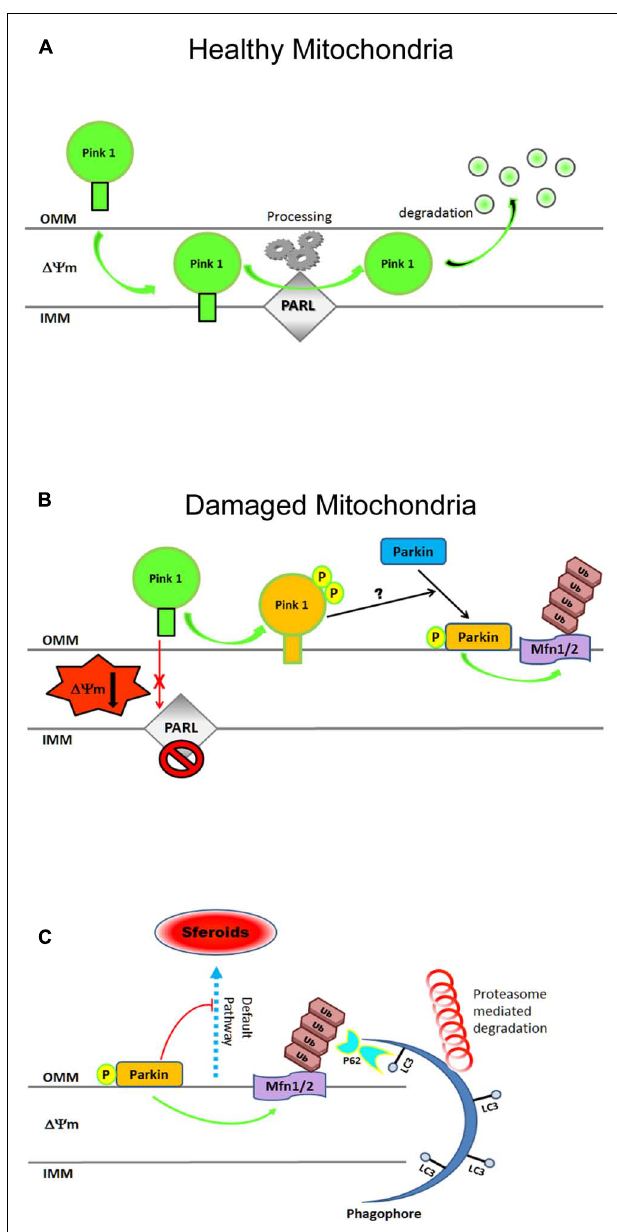
FIGURE 3 | Cartoon illustrating steps in the mitochondrial clearance mediated by the Pink1–Parkin pathway. (A) In physiological conditions, Pink-1 is constitutively imported into healthy mitochondria viaTIM/TOM complex to the inner membrane (IMM), cleaved by presenilin-associated rhomboid-like protease (PARL), and then proteolytically degraded. (B) Upon (cid:2)(cid:3) collapse, full-length Pink1 is not processed accumulating at the outer membrane (OMM) to recruit Parkin onto depolarized mitochondria. PINK1 autophosphorylation at Ser228 and Ser402 (P) is essential for efficient mitochondrial localization of Parkin.The PINK1-dependent Parkin phos- phorylation at Ser65, combined with unknown factor(s) (?), is required not only for its efficient translocation but also for the degradation of mito- chondrial proteins during mitophagy. (C) After being recruited on OMM, Parkin triggers mitophagy by ubiquitylating (Ub, K48, K63) several proteins including Mfns1/2,VDAC,TOM. Proteasome-mediated removal of Mfns1/2 not only inhibits mitochondrial fusion but also prevents its default rear-